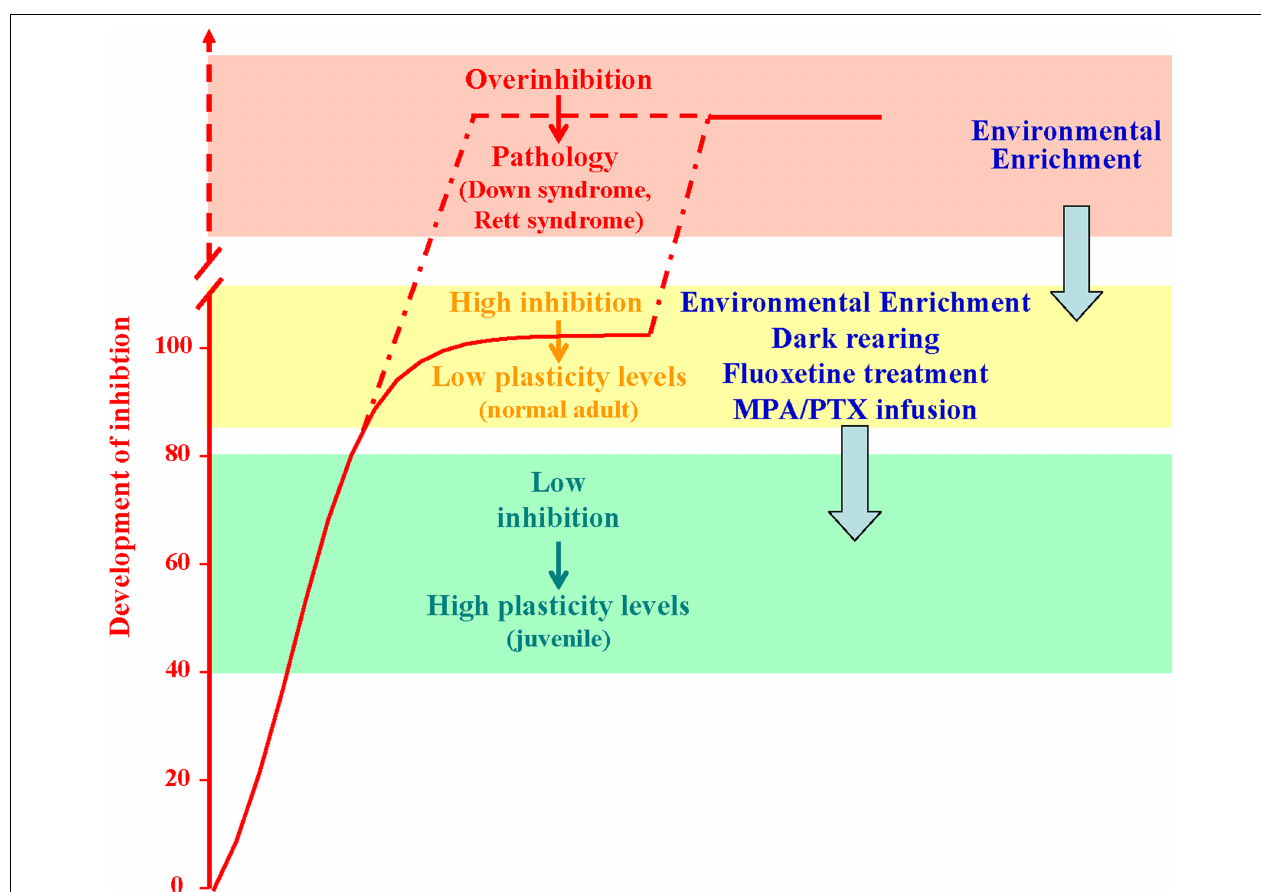
FIGURE 2 | Developmental increase of brain GABAergic inhibition levels (normalized to the normal adult values; red curve) is paralleled by a progressive reduction of experience-dependent plasticity. Plasticity is high during early development (green block) and very low in the adult brain (yellow block). Anomalous increases in the strength of inhibitory neural circuits may lead to over-inhibition linked to permanent defi cits in